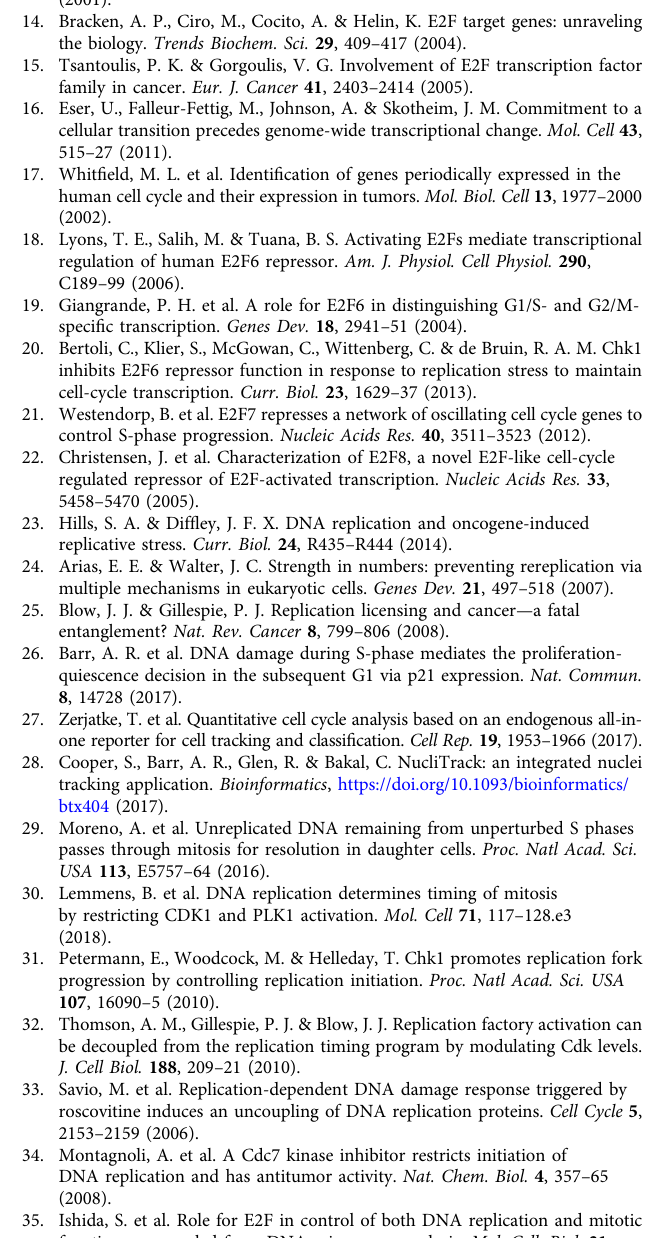
Fig. 4 An increase in E2F-dependent transcription in S phase results in accumulating DNA damage in later cycles. a RPE1 cells were synchronised by contact inhibition, reverse transfected upon release into the cell cycle, and levels of chromatin-bound RPA2 and γ H2AX were quanti fi ed by immuno fl uorescence during the fi rst S phase (21 h) and second cell cycle (41 h) after release. Black, non-S phase cells (RPA2 < 50 A.U.); orange and red dots, low and high levels of γ H2AX, respectively (arbitrary γ H2AX threshold = 50 A.U.). Data are representative of three independent experiments, scale bar represents 20 μ m. b Percentage of arrested and dividing cells were quanti fi ed from live imaging of RPE1 mRuby-PCNA p21-GFP cells through two divisions. Mean and S.D. from two independent experiments shown. c Length of G1 phase calculated from live imaging of RPE1 mRuby-PCNA p21-GFP. siCont n = 75, siE2F6, n = 58. Mean and S.D. are shown. d Quanti fi cation of p21 levels in RPE1 mRuby-PCNA p21-GFP cells through two divisions. Images of p21 and PCNA fl uorescence intensity 56 h after commencement of imaging, scale bar = 50 μ m. Median with 95% con fi dence intervals are shown. siCont n = 22, 22 and 25 mother, daughter and grand-daughter cells, respectively, siE2F6a n = 33, 30, 44. e , f E2F activity determines replication capacity, which limits DNA synthesis rate to provides a general mechanism to ensure timely completion of S phase largely independent of replication-initiation events. Signi fi cance was determined by a two-tailed Mann – Whitney test for each marker compared to control at each timepoint ( a ) and compared to control within each generation ( d ), and Kruskal – Wallis test with Dunn ’ s multiple comparisons test (